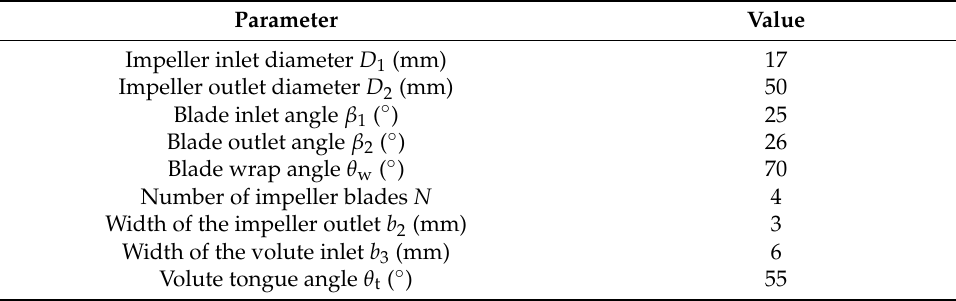
Table 1. Main parameters of the original pump.